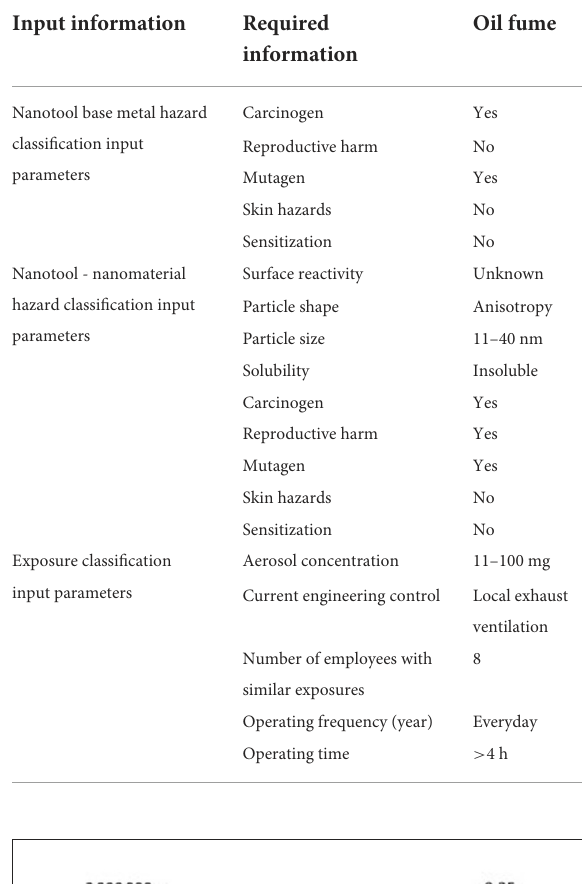
TABLE 3 Hazard parameters and exposure scenario parameters of oil fume.